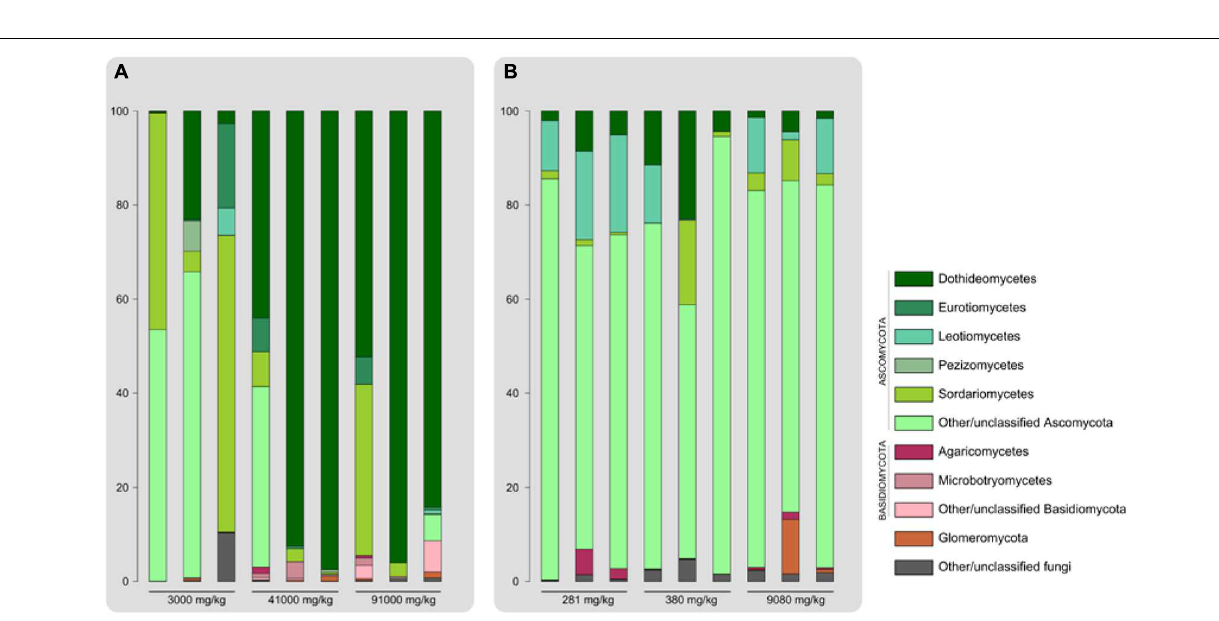
Frontiers in Microbiology |